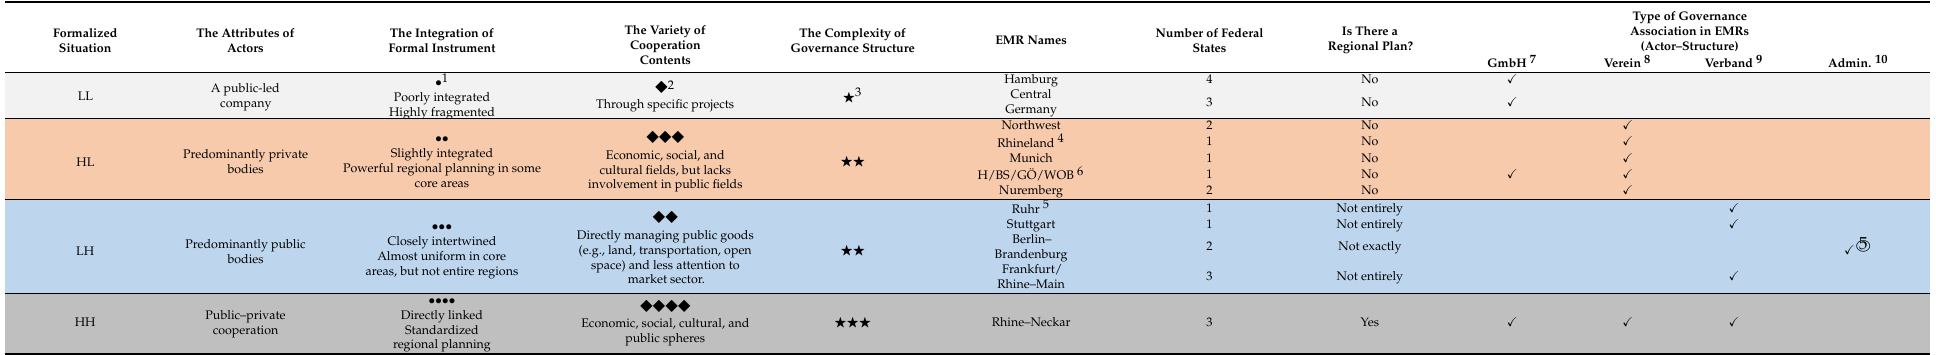
Table 1. Explanation of the four groups of EMRs in Germany—participant attributes, integration of formal instruments, status of regional planning, and their governance